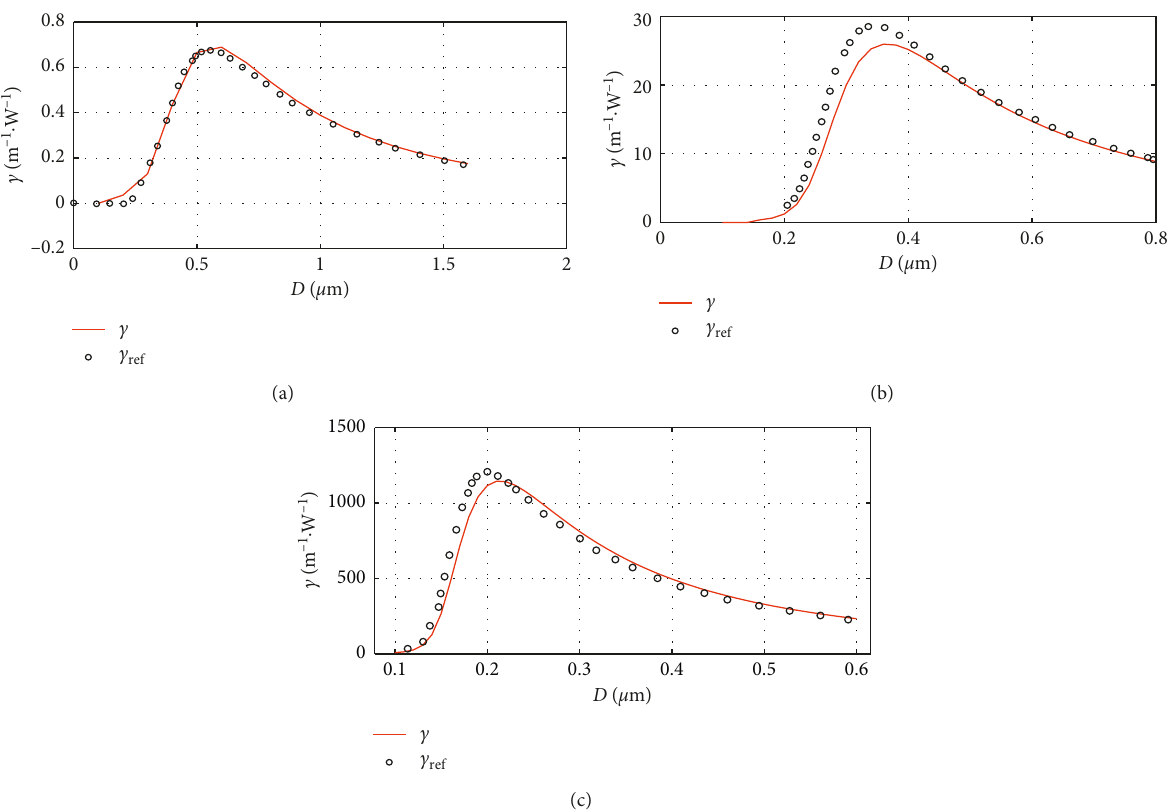
Figure 6: Nonlinear parameter c at λ � 800nm as a function of the core diameter obtained by the HFHE formulation (continuous line) and results given in [22, 23] (dots). (a) Silica rod: n